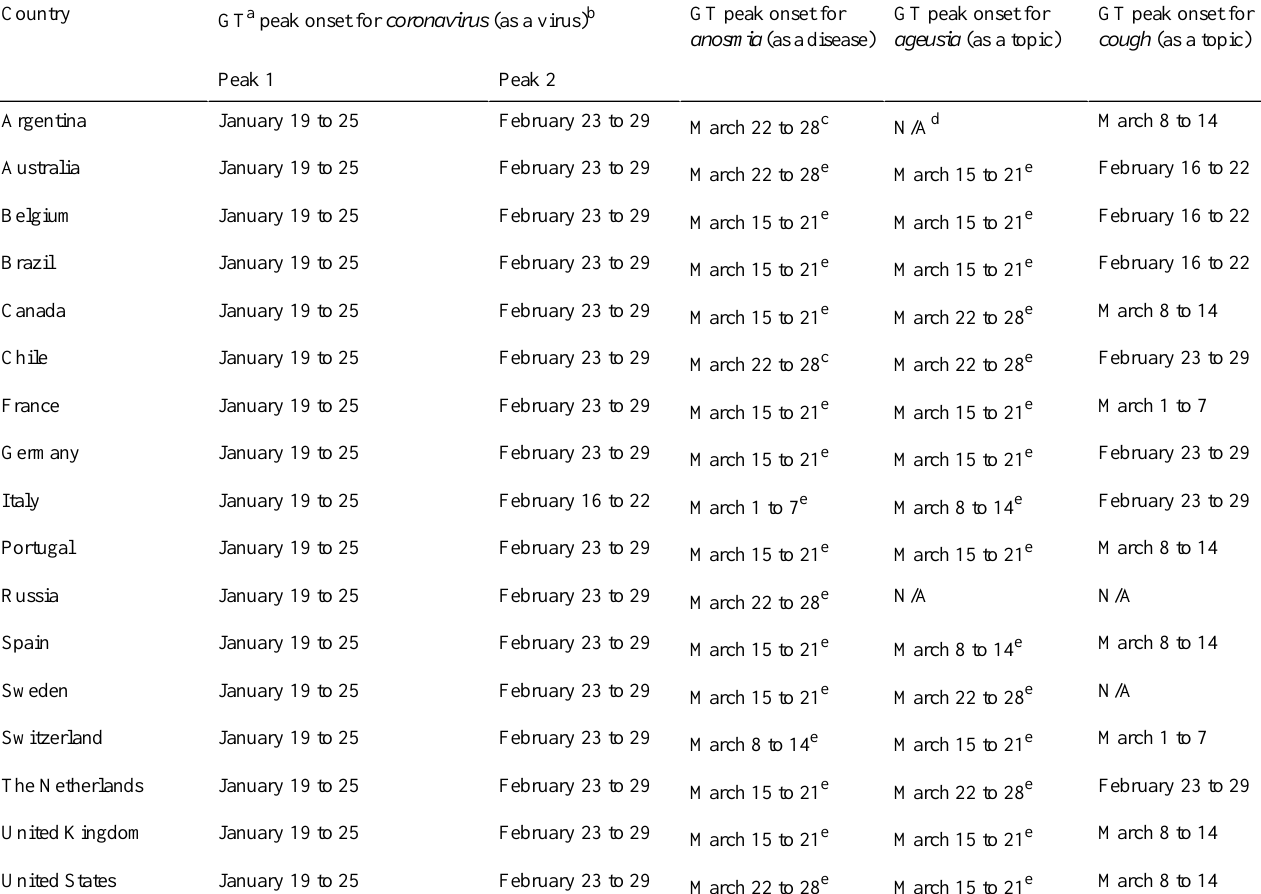
Table 1. Weeks of onset of Google Trends peaks for search terms related to COVID-19 in 2020 in 17 countries.